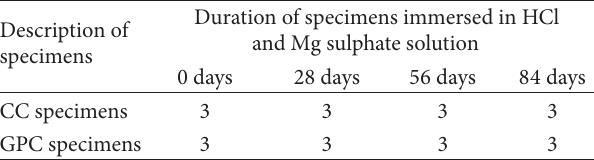
Table 6: Details of the experimental